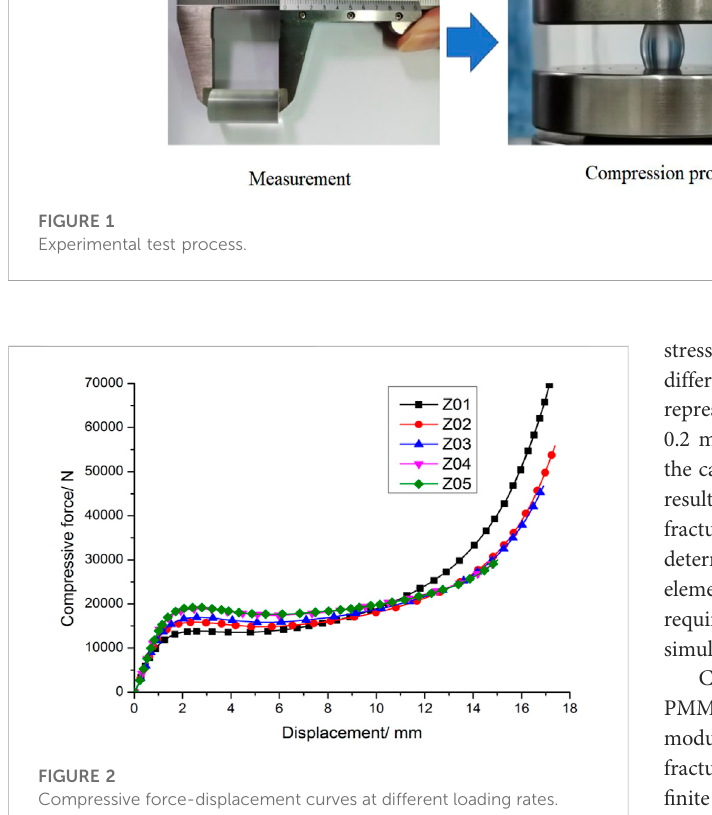
Figure 5 depicted the stress nephogram of sample. As can be seen, the cylinder sample bulges in the middle under pressure, and then breaks under the action of tension, which conforms to the experiment.